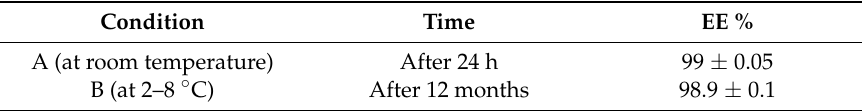
Figure 3. Particle size changes in formulation I ( a ) and formulation III ( b ) at 2–8 °C (condition B). Table 3. Encapsulation efficacy (EE %) of the DTX in the nanomicelles for long term and short term stability studies.